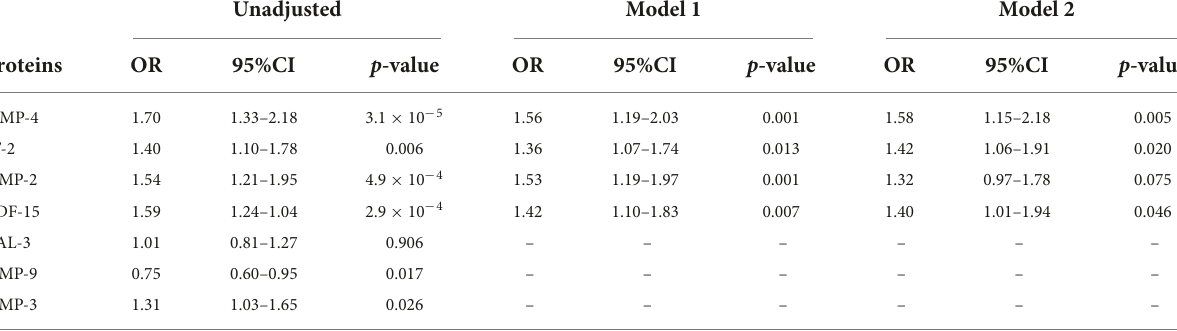
TABLE 2 Logistic regression analysis examining proteins association with prevalent atrial fibrillation.